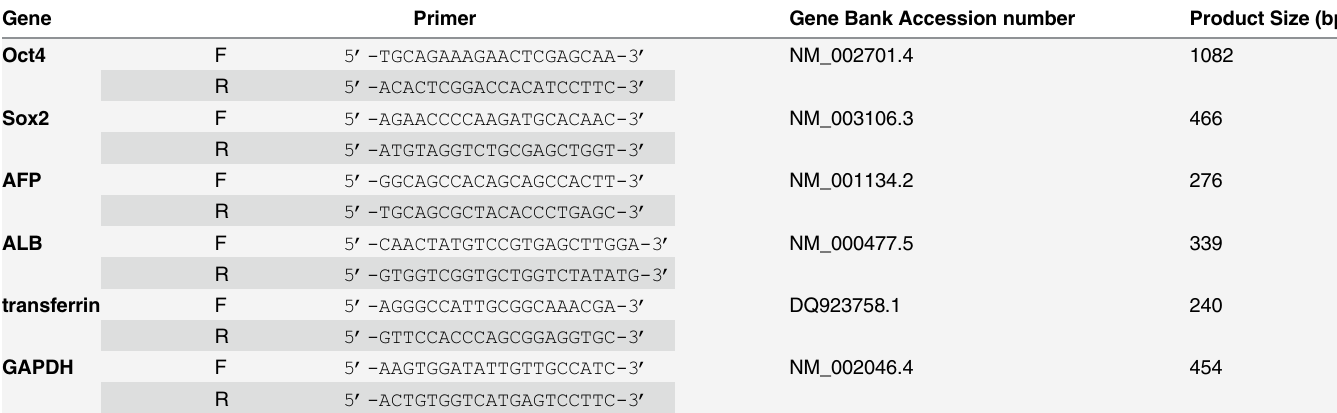
Table 1. Primer sequences for RT-PCR amplification of target genes.